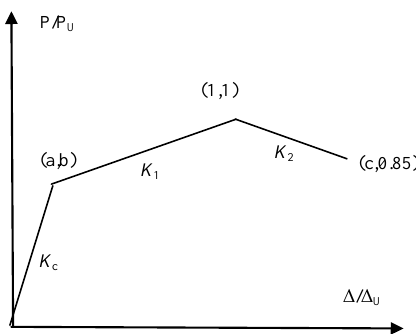
K 2 Figure 15. Trilinear substitute model of envelope curves.